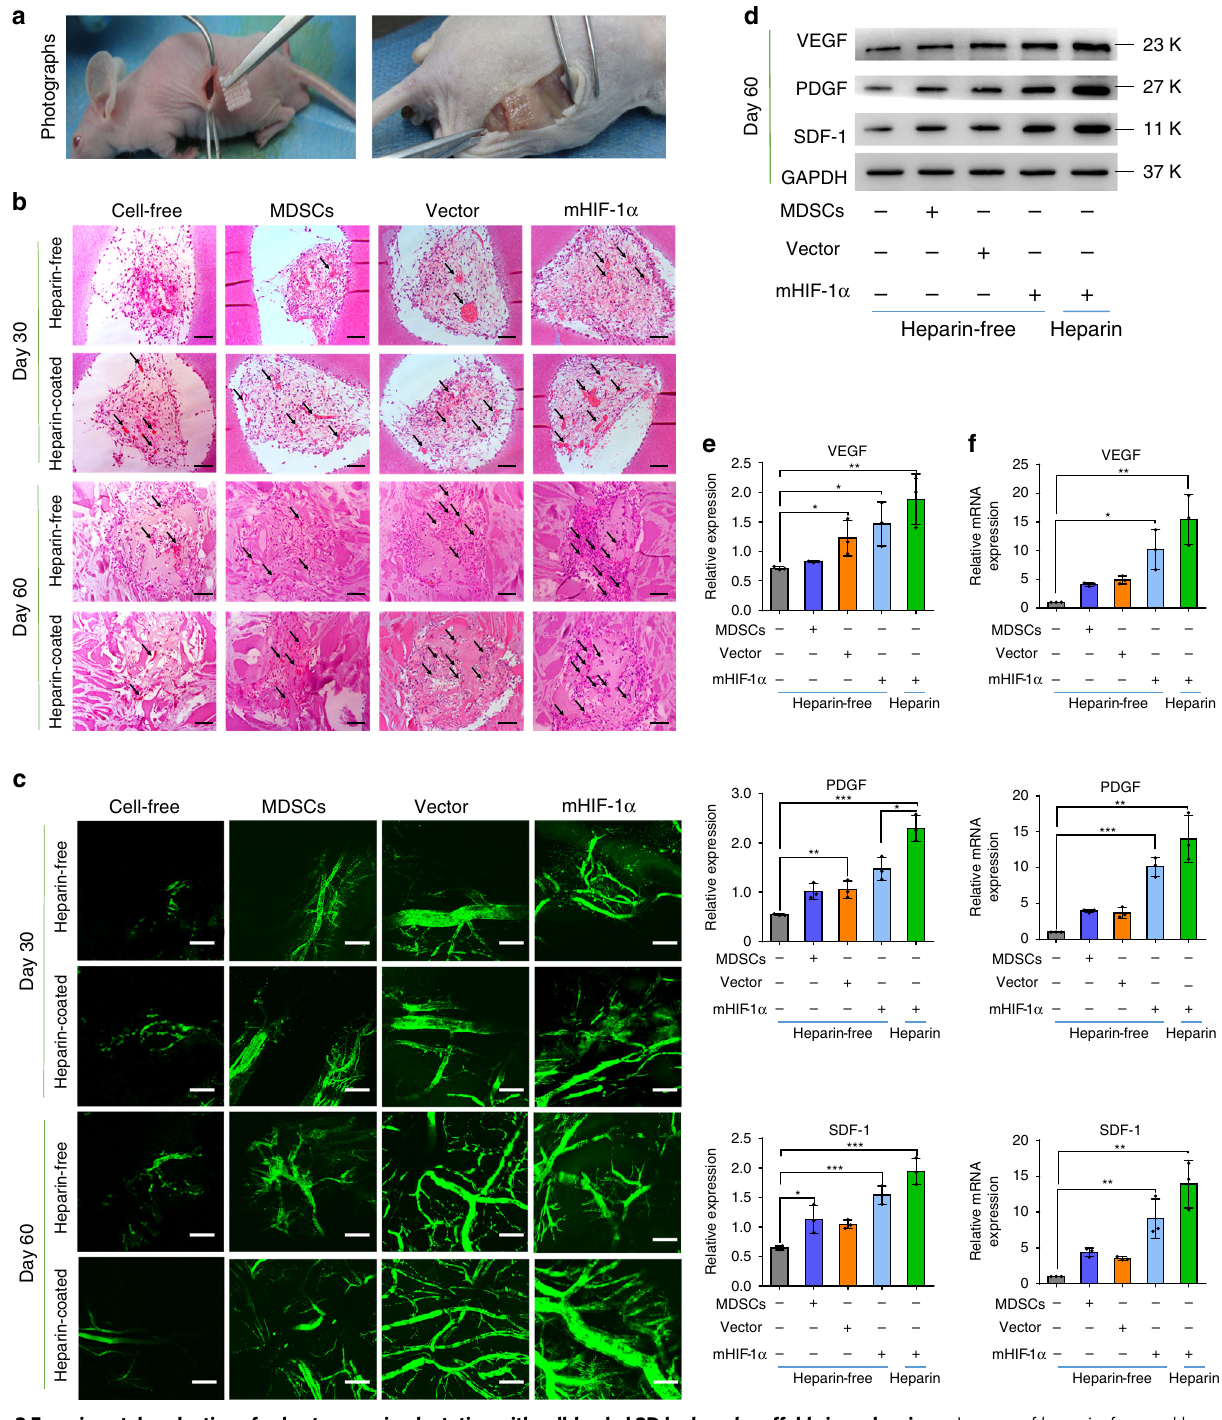
Fig. 3 Experimental evaluation of subcutaneous implantation with cell-loaded 3D hydrogel scaffolds in nude mice. a Images of heparin-free and heparin- coated 3D hydrogel scaffolds loaded with different cells before and 60 days after subcutaneous implantation. b Images of H&E staining in the cell-free, MDSCs, vector and mHIF-1 α groups after implantation in nude mice for 30 and 60 days. The scale bar is 100 μ m ( n = 3). c Three-dimensional angiography images of blood vessels in two implanted scaffolds after implantation in nude mice for 30 and 60 days. The scale bar is 100 μ m ( n = 3). d , e Expression of VEGF, SDF-1 and PDGF at the protein level via WB detection in the scaffold tissue after 60 days ( n = 3). (Unpaired, two-tailed t -test. In e -VEGF, ** p = 0.0093, mHIF-1 α + Heparin-free vs Control * p = 0.0249, Vector + Heparin-free vs Control * p = 0.0434; in e -PDGF, *** p = 0.0003, ** p = 0.0079, * p = 0.016; in e , SDF-1, mHIF-1 α + Heparin vs Control *** p = 0.0006, mHIF-1 α + Heparin-free vs Control *** p = 0.0006, * p = 0.0249). f Comparative gene expression analysis of VEGF, PDGF and SDF-1 via qRT-PCR assay in the implanted scaffold tissue after 60 days ( n = 3). (Unpaired, two-tailed t -test. In f , VEGF, ** p = 0.0045, * p = 0.0104; in f , PDGF, ** p = 0.0025, *** p = 0.0003; in f , SDF-1, mHIF-1 α + Heparin vs Control ** p = 0.0025, mHIF-1 α + Heparin- free vs Control ** p = 0.0069). Data are displayed as mean ± SD. (* p < 0.05, ** p < 0.01, *** p <